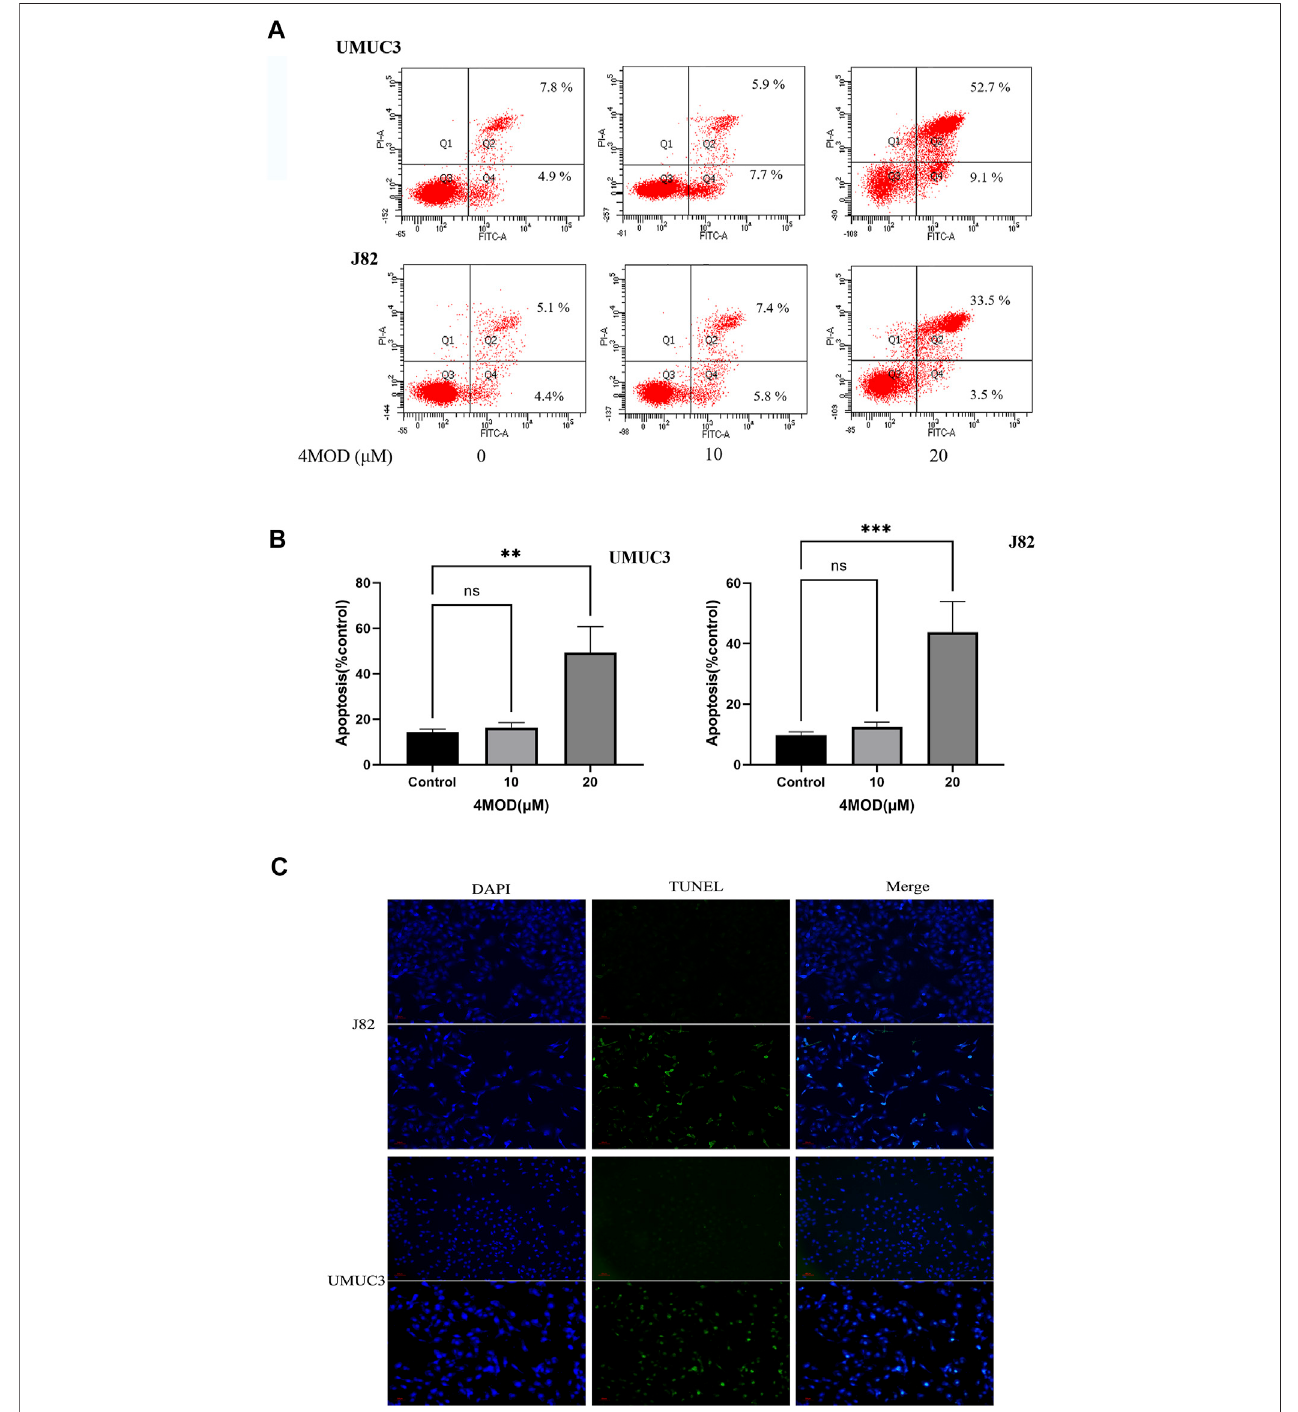
FIGURE 3 | 4MOD promotes apoptosis of BC cells. The cell apoptosis was measured by fl ow cytometry analysis (A-B) and TUNEL assays (C) in BC cells of J82 and UMUC3. Data are presented as mean ± SD. Statistic signi fi cant differences were indicated: * p < 0.05, ** p < 0.01, *** p < 0.001.